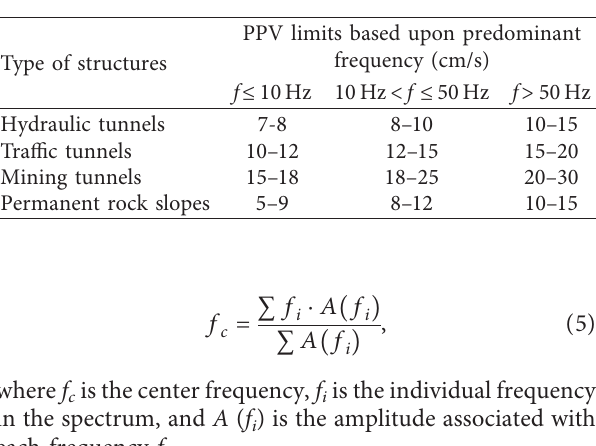
Table 1: PPV limits for tunnels and rock slopes in the Chinese standard from